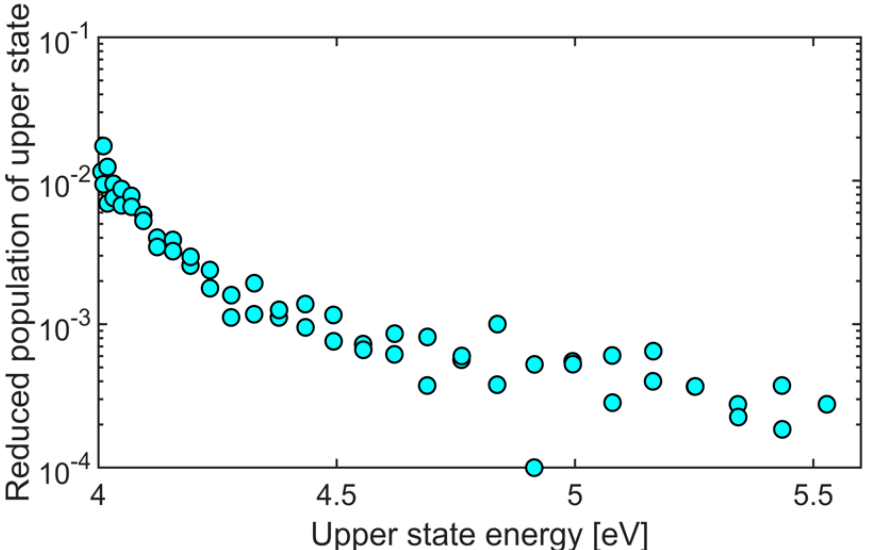
Figure 6. Typical example of the Boltzmann plot of the state-by-state fitting of the OH (A-X) emission spectrum of the HCPJ performed using the massiveOES package. Only υ ’ = 0 transitions are shown. Figure 7 shows a single period of the HCPJ current and voltage at reduced backpressure of 40 kPa and at HV power supply input power of 400 W and a frequency of 65 kHz. The current flowing through the reactor and voltage measured at the discharge electrodes are slightly phase shifted, which indicates the complex impedance of the HCPJ with the prevailing resistive part and capacitive reactance dominating the imaginary part. At the given conditions, the peak-to-peak value of HV was approximately 6.4 kV and the peak-to-peak value of the current was approximately 300